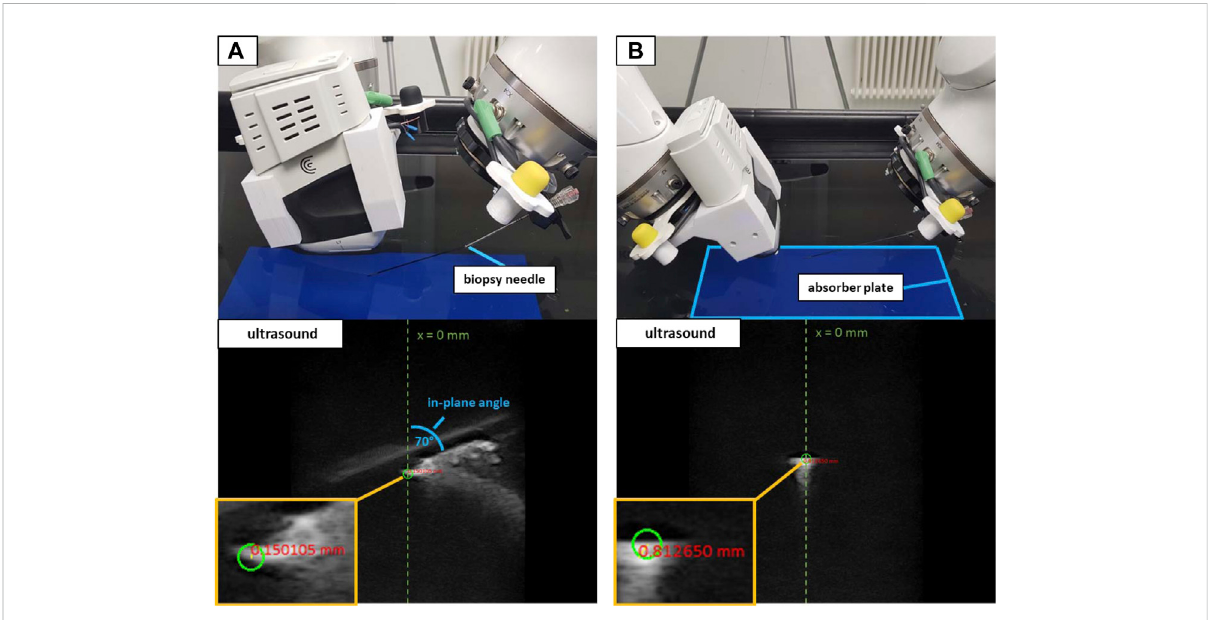
FIGURE 7 Thewaterbathsetupwithin-planepositioningat70 ° (A) andorthogonalpositioning (B) .WhiteartifactsintheUSimagesdepictthere fl ectionsof the needle. The green circles show the planned target at x = 0 mm and a depth = 40 mm. The red numbers show the distance from the planned target to the approximated center of the needle tip in the US image.